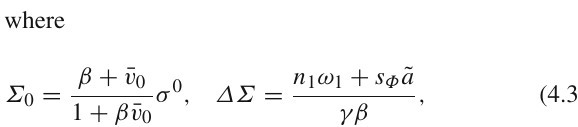
Fig. 12 depict approximate finite closed dressed strings with n 2 = 1. Two indicative examples of dressed solutions with n 2 > 1 are depicted in Fig.